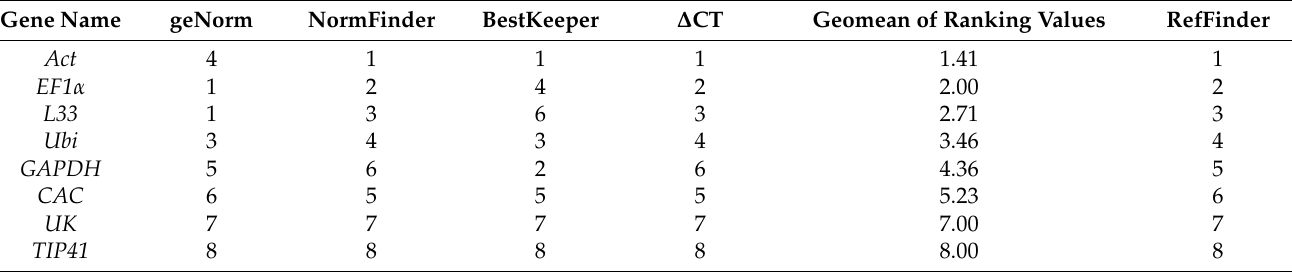
Table 5. Ranking of reference gene stability in the entire dataset of ‘MM’ and ‘62579 (cid:48)